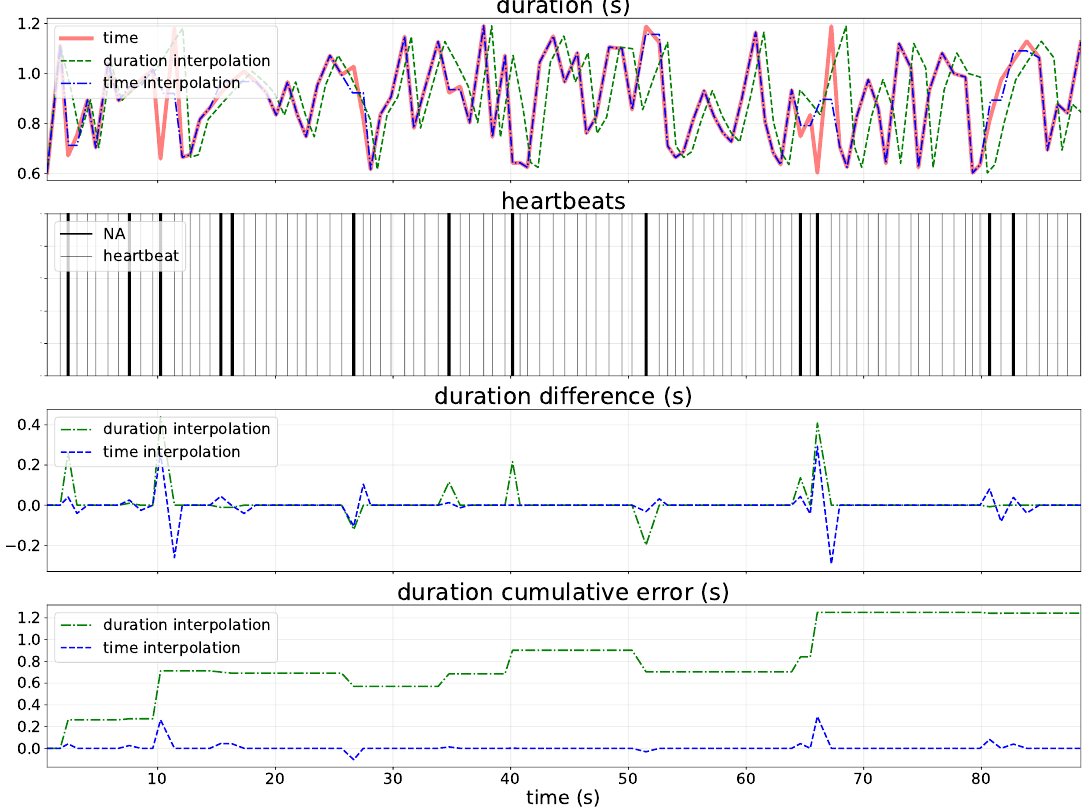
Figure 4. Difference between linear interpolation on time and duration. Red solid line refers to real variation of the timing between beats (RR-intervals) time series, green dashed line refers to the on-duration approach, and green dot dash line refers to the on-time